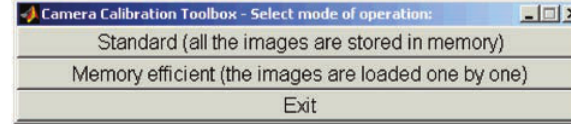
Table 2. The models of the image